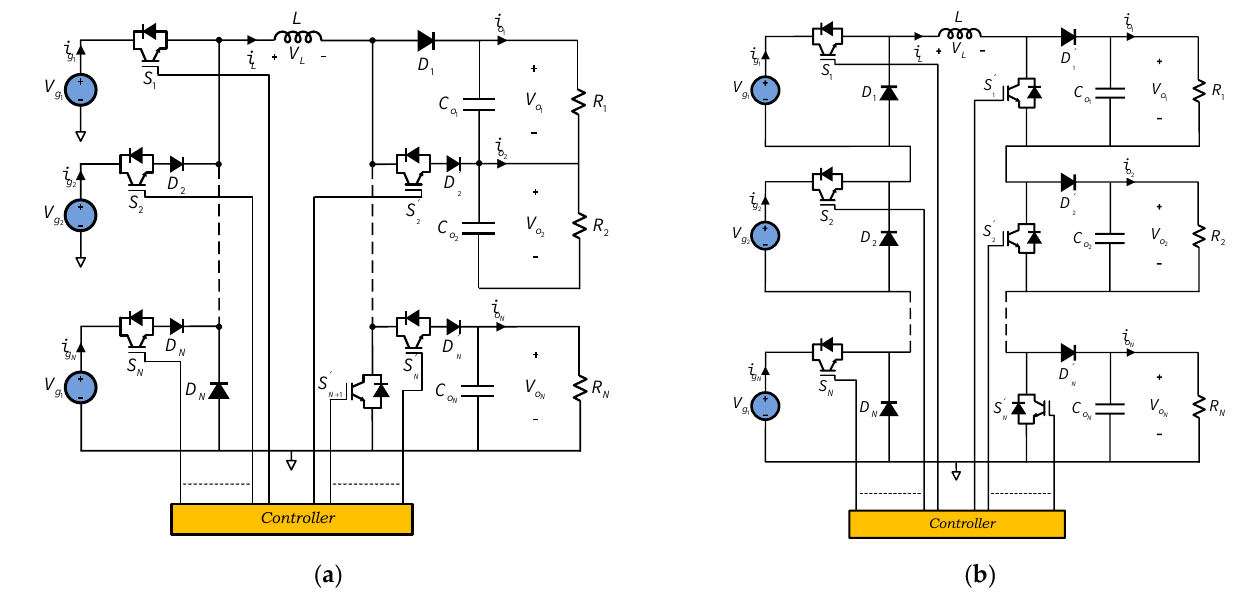
Figure 12. Non-isolated single-inductor MIMO Converters. ( a ) Series outputs [83 – 85]. ( b ) Series inputs and series outputs [44,86]. Table 8. Comparative summary of MIMO DC – DC Converters Non-Isolated.